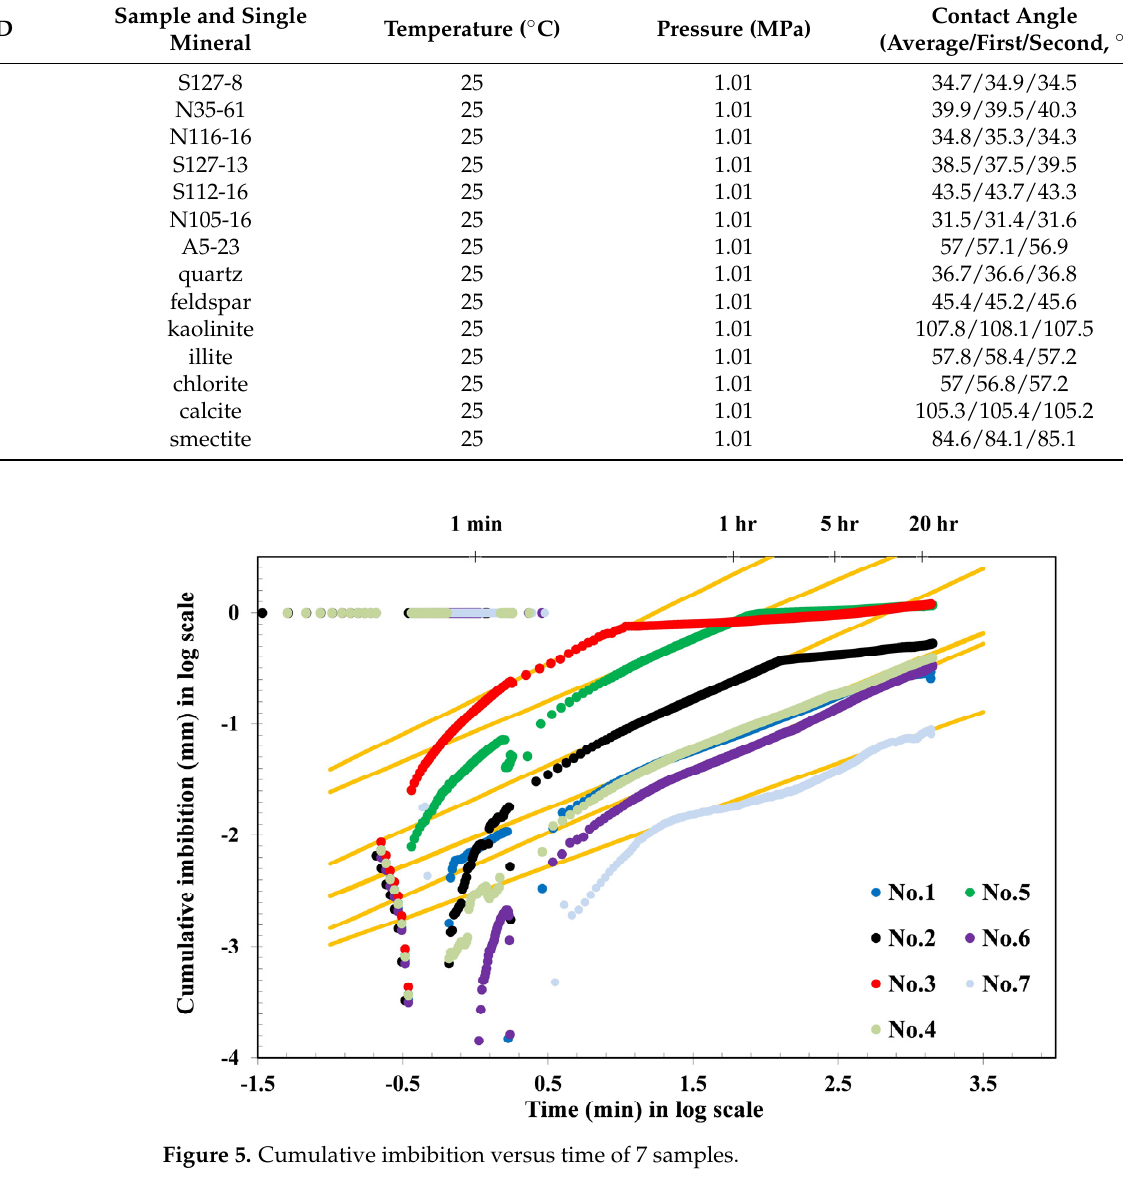
Figure 5. Cumulative imbibition versus time of 7 samples.